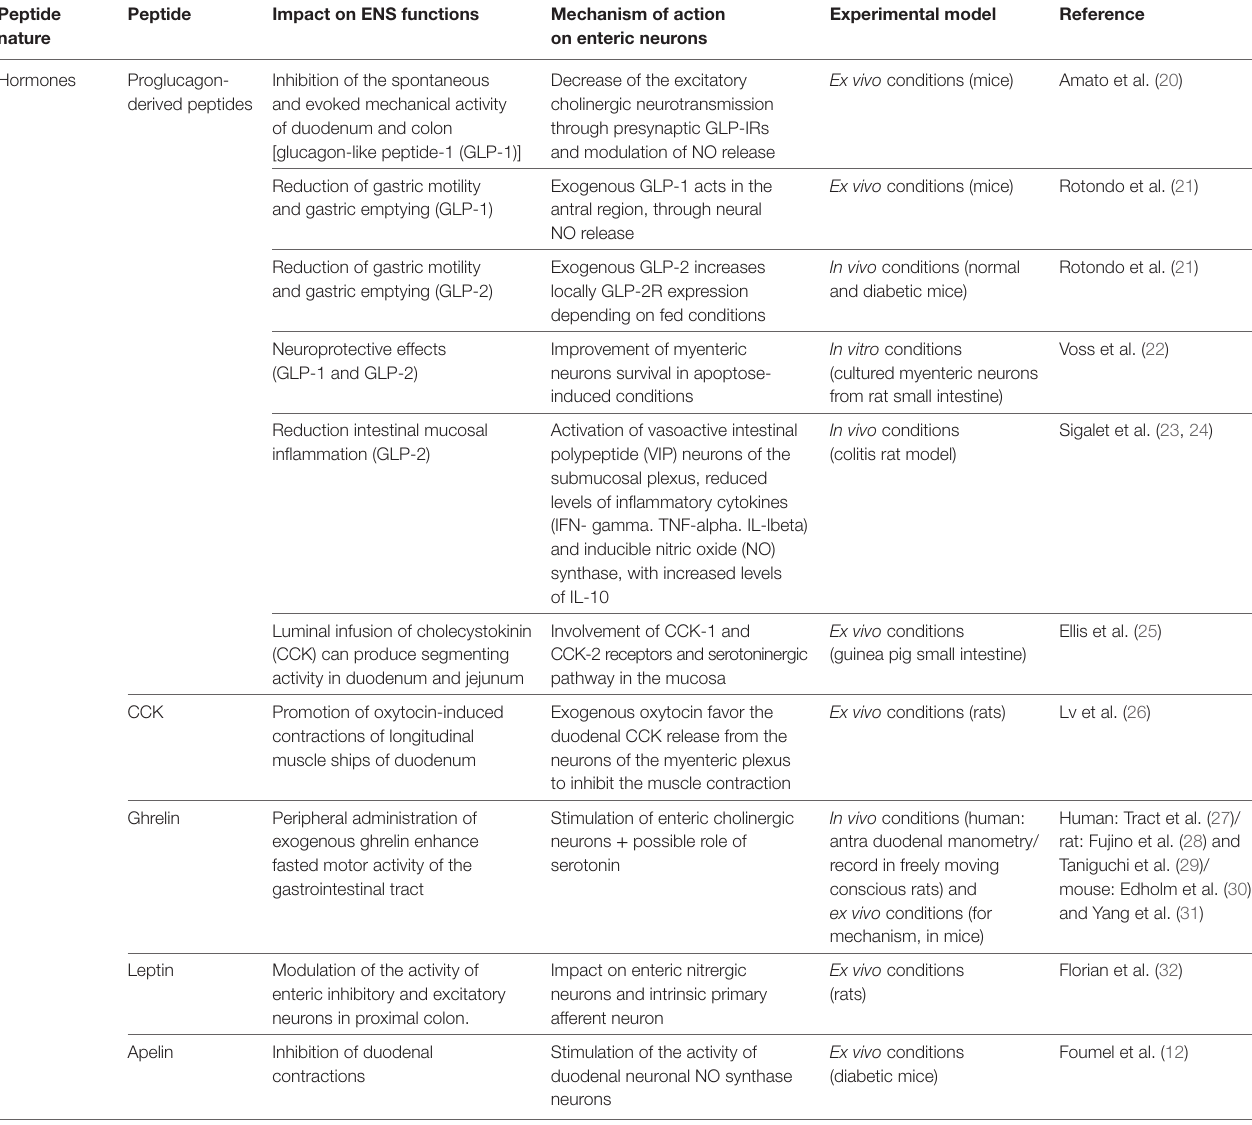
TAble 1 | Hormones and neuropeptides implicated in the control of enteric nervous system (ENS). Peptide